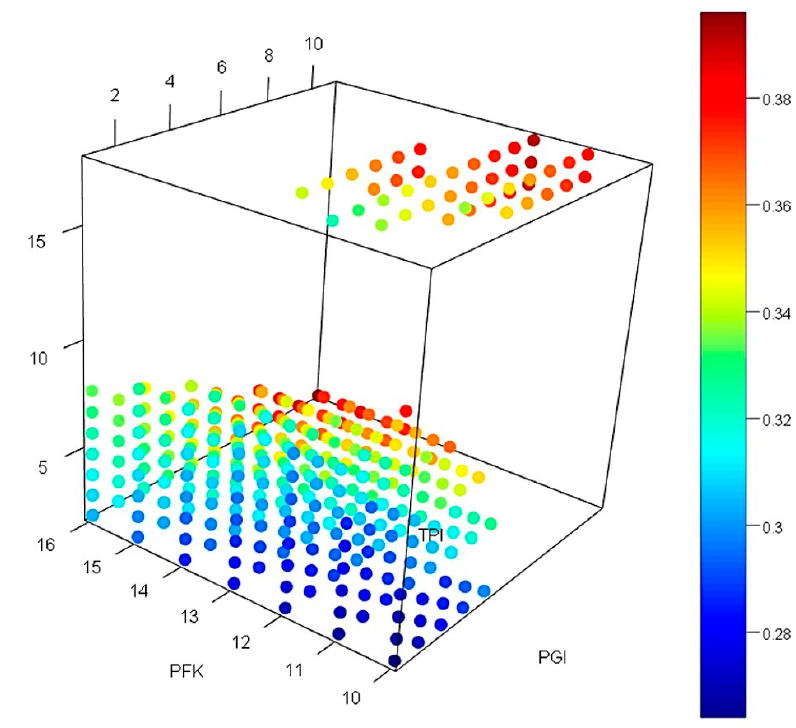
Figure 13. 3D-representation of the cost estimated for the enzyme concentration that obeys the rule obtained for higher flux values. The color gradient is according to the cost required for each balance, blue is the lowest and red is the highest cost for a selected balance of the four enzymes PGI, PFK, FBA and TPI.